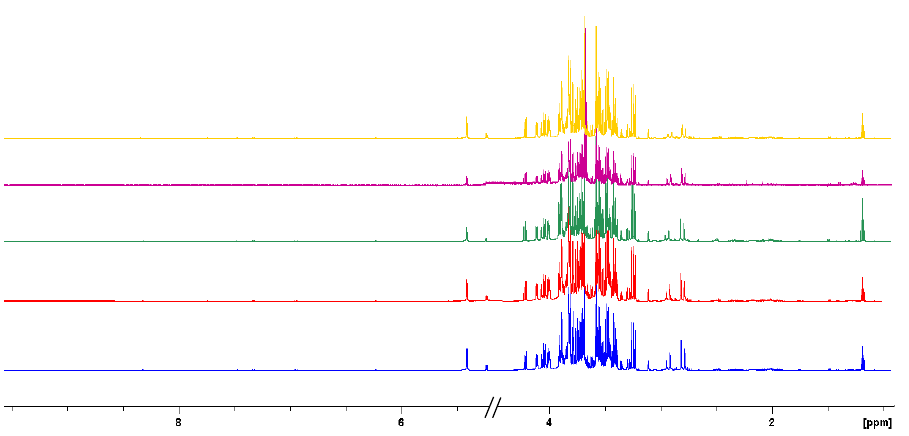
Figure 5. Comparison of 1 H ‐ NMR spectra of FUF (in blue), RUF (in red) PUF (in green), RDF (in violet), and PDF (in yellow) Tacle samples.